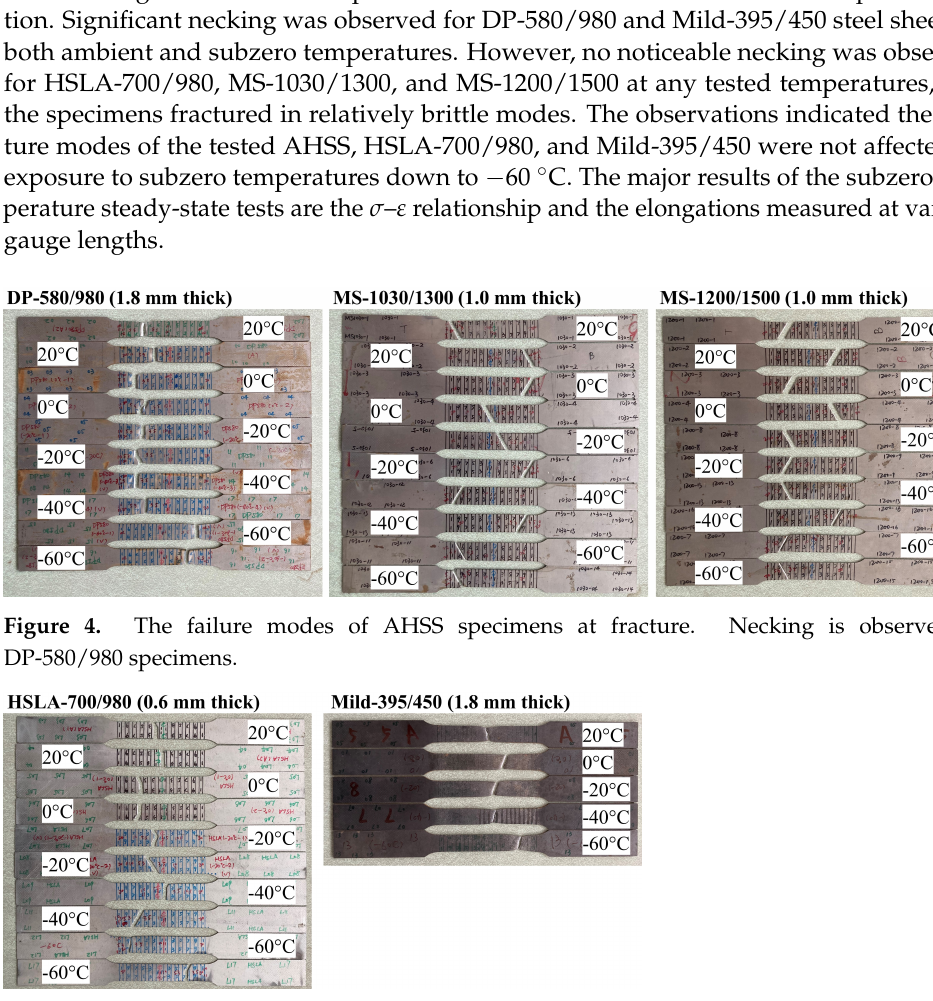
Figure 5. The failure modes of HSLA-700/980 and Mild-395/450 specimens at fracture. Necking is observed in Mild-395/450